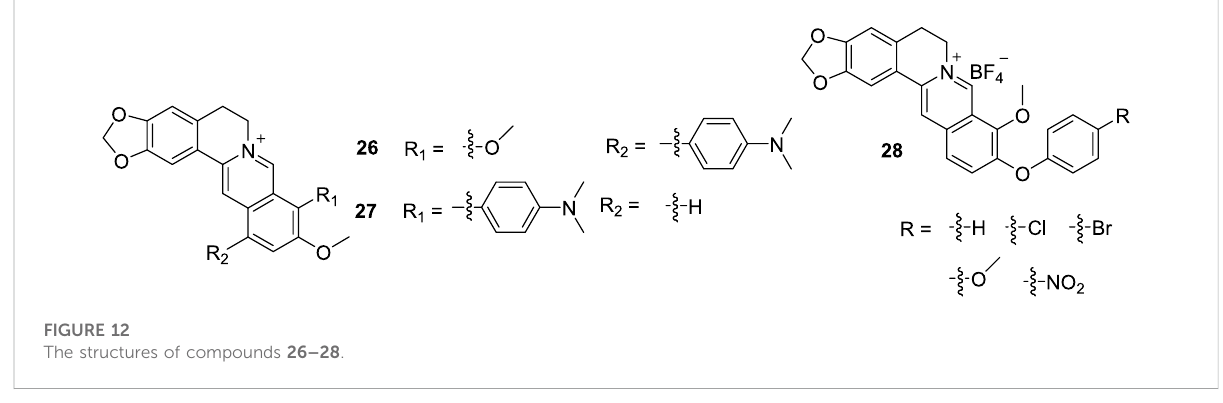
FIGURE 12 The structures of compounds 26 – 28 .